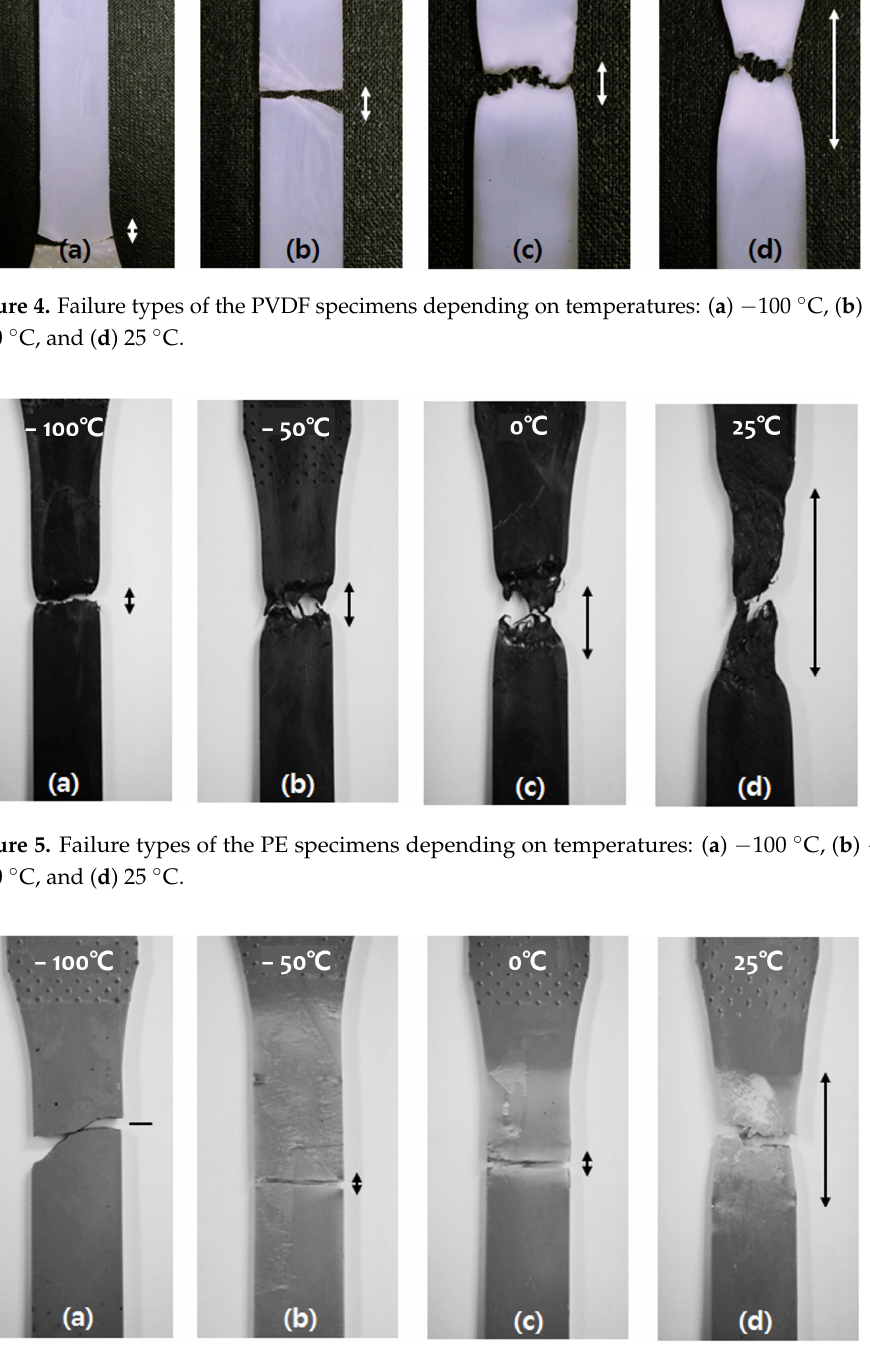
Figure 6. Failure types of the ABS specimens depending on temperatures: ( a ) − 100 °C, ( b ) − 50 °C, ( c ) 0 °C, and ( d ) 25 °C.